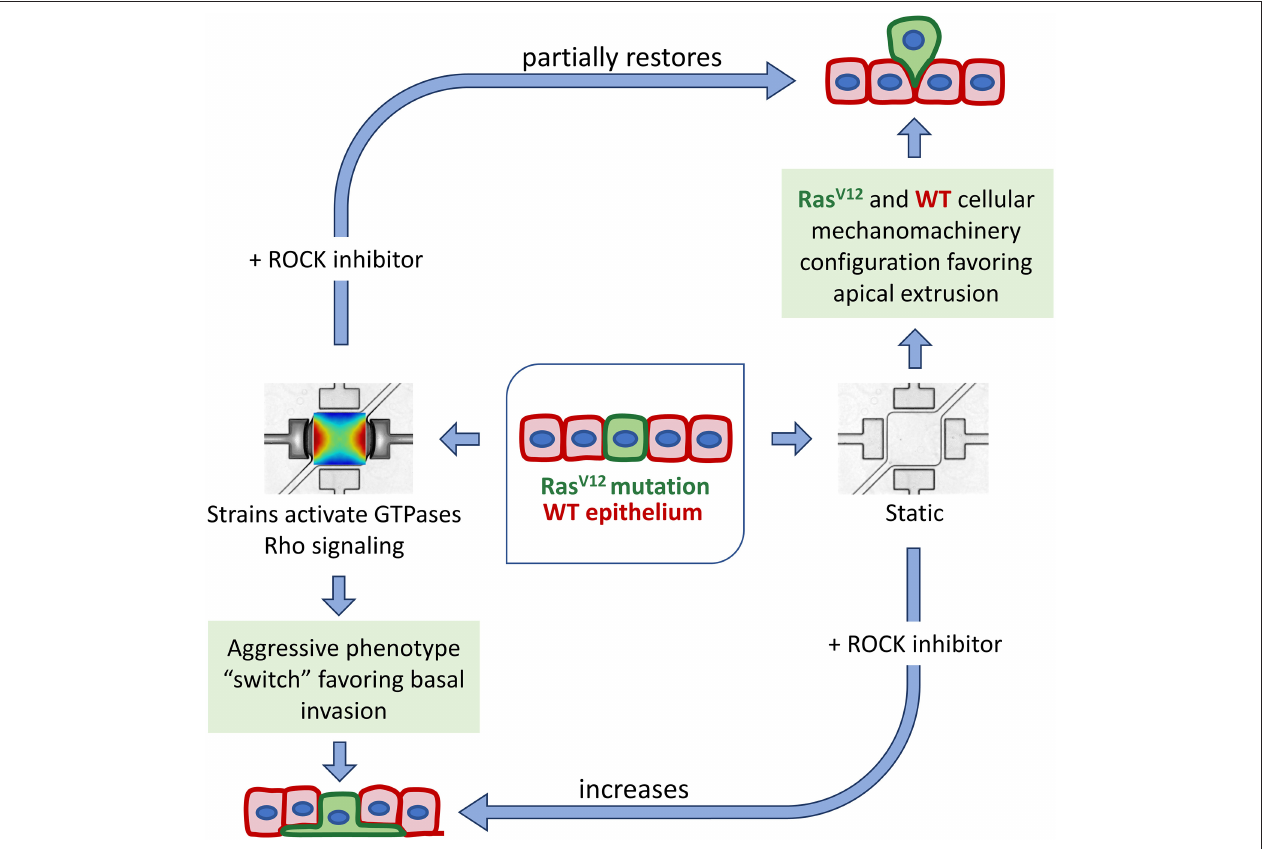
FIGURE 4 | Scheme of the mechanically-induced switch to aggressive phenotype, showing the involvement of the Rho-ROCK mechanotransduction pathway. Under static condition, the specific Ras V12 and WT mechanomachinery configuration favors apical extrusion processes. A perturbation to this system, via mechanical stretching, abolishes the formation of the actin belt around Ras V12 cells and potentiate Ras V12 protrusion growth. The addition of ROCK inhibitor in a mechanically dynamic microenvironment partially restores the cortical actin belt around Ras V12 cells and the apical extrusion